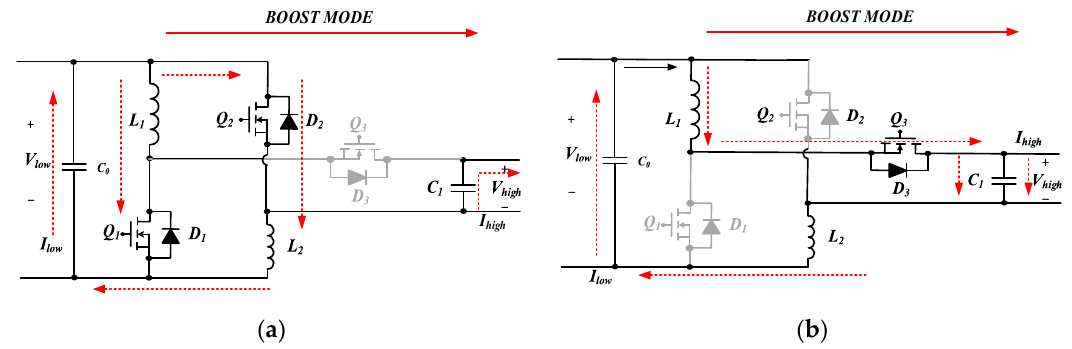
Figure 10. Topological states of converter III in boost mode. ( a ) [ t 0 –t 1 ]. ( b ) [ t 1 –t 2 ].